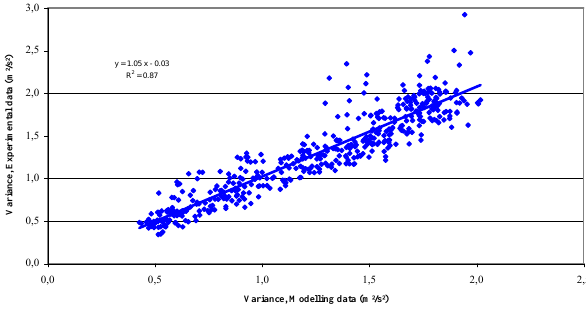
Figure 9: Variance. Comparison between the experimental and the modeled data, for α =1.20 and δ =1.36 (Plot RT, Level 2)